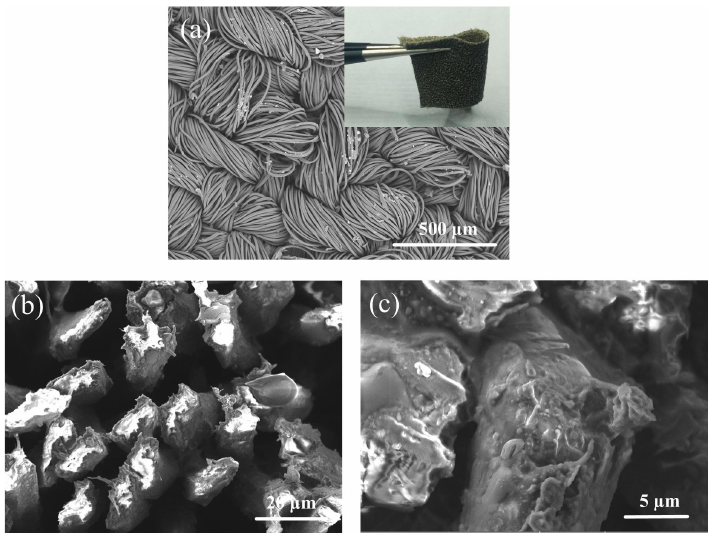
Figure 2. ( a ) The photograph of graphene textile sensor under low magnification. ( b ) The cross-sectional SEM image of graphene fibres at 3000 × magnification. ( c ) at 10,000 × magnification.